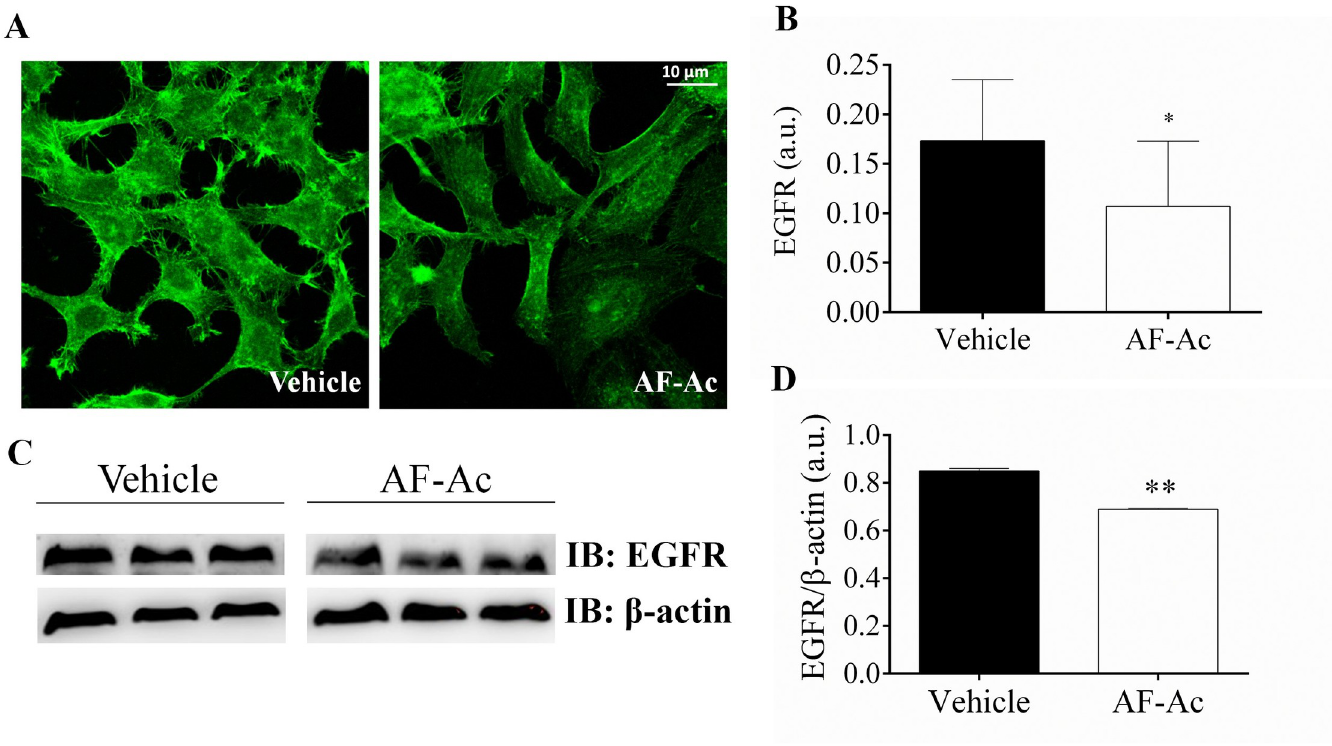
Fig 7. Representative immunofluorescence images of HepG2 cells treated with 50 μ g/mL AF-Ac or vehicle (control, cells treated with DMEM medium containing 0.05% DMSO) labeled with specific anti-EGFR (green) antibody. Scale bar = 10 μ m (A). Average number of EGFR–positive regions for the cell types analyzed are shown as EGFR/1000 μ m 2 on each respective graph (n = 20 cells/group) (B). Representative cropped immunoblotting of total HepG2 cell lysates probed with anti-EGFR and anti- β -actin, used as protein loading control (C). Immunoblotting densitometry analysis. Results show β -actin normalized proteins expression (n = 3 individual experiments/group) (D). Values are expressed as mean ± SD. Significance levels are indicated by �� p < 0.01 (unpaired t-test). Each protein was analyzed in cropped membranes of different Western blots along with other proteins. Full-length blots are presented in S1 Raw